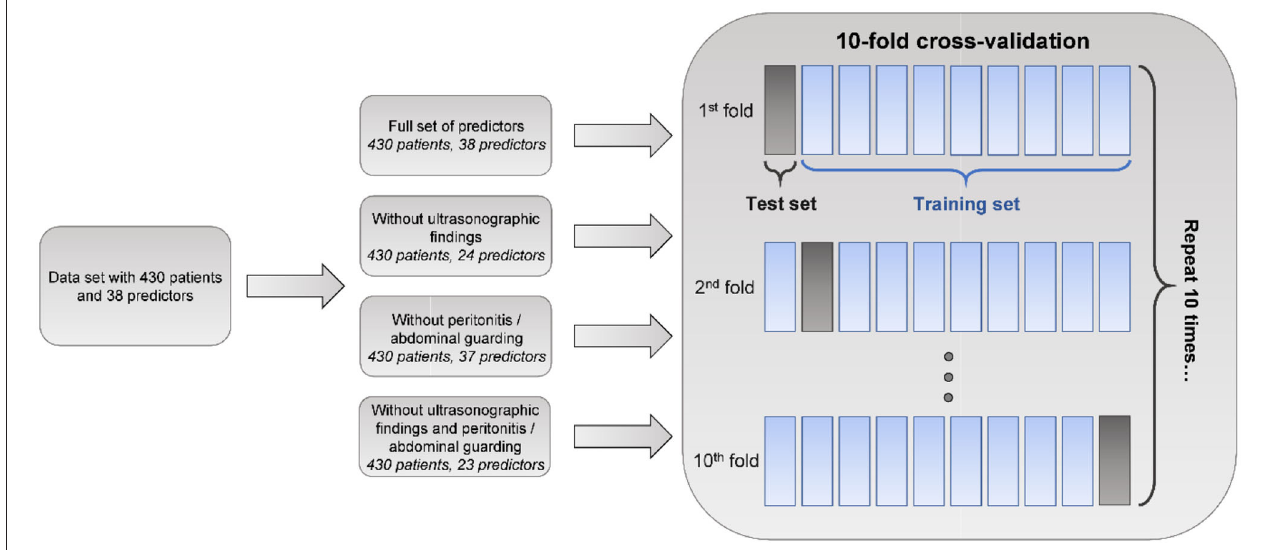
FIGURE 1 | Machine learning analysis schematic. Machine learning models, namely logistic regression (LR), random forest (RF), and generalized boosted regression model (GBM), based on various sets of predictor variables, are evaluated using areas under receiver operating characteristic (AUROC) and precision-recall (AUPR) curves in the 10-fold cross-validation procedure. Ten-fold cross-validation is a standard procedure for evaluating the performance of predictive ML models wherein the model is trained on 90% of the data and tested on the remaining 10% repeatedly for 10 disjoint test folds. In our analysis, missing value imputation was performed separately for train and test sets using the k -nearest neighbors ( k -NN)